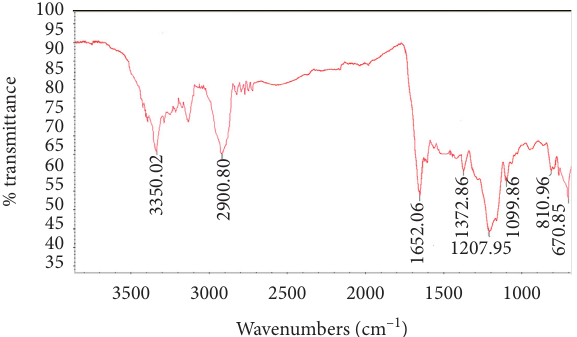
Figure 3: FTIR spectrum of the ACF resin.